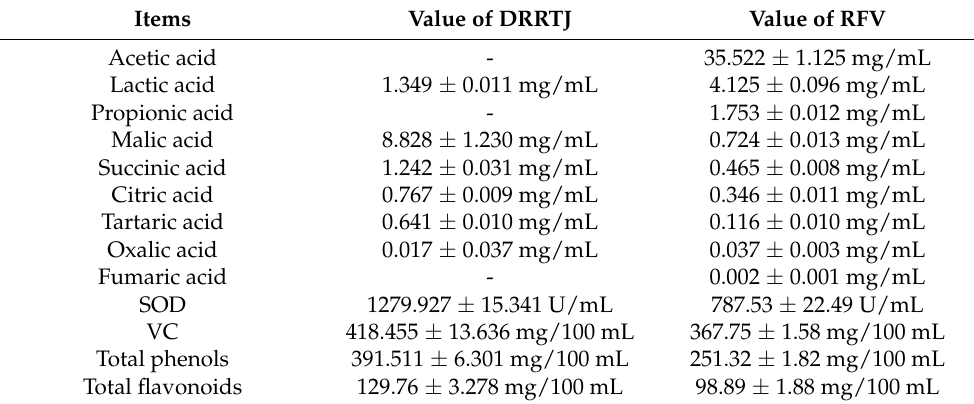
Table 1. Nutritional composition of DRRTJ and RFV.